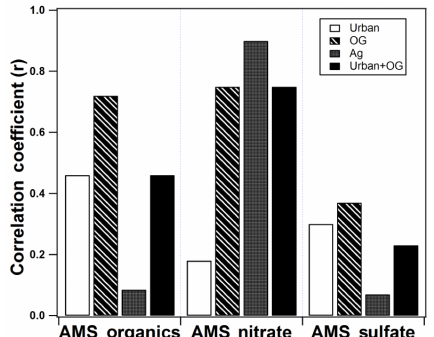
Figure 4. Correlations coefficients of β ext vs. aerosol composition for urban, O&G, agriculture, and urban + O&G